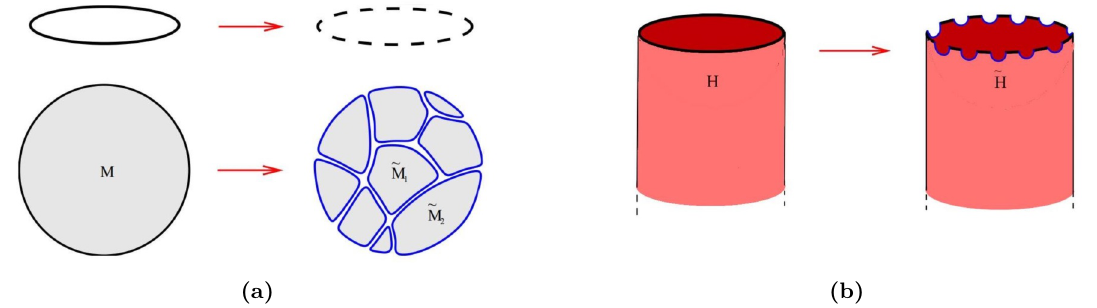
(a) BCFT-bit systems approximating holographic 1+1 and 2+1 dimesional CFTs. (b) Path integral defining the state of BCFTs approximating the vacuum state of a holographic 1+1 dimensional CFT. In the limit where the modifications to the original path integral are small, the dual geometry faithfully approximates an arbitrarily large causal patch of the original AdS